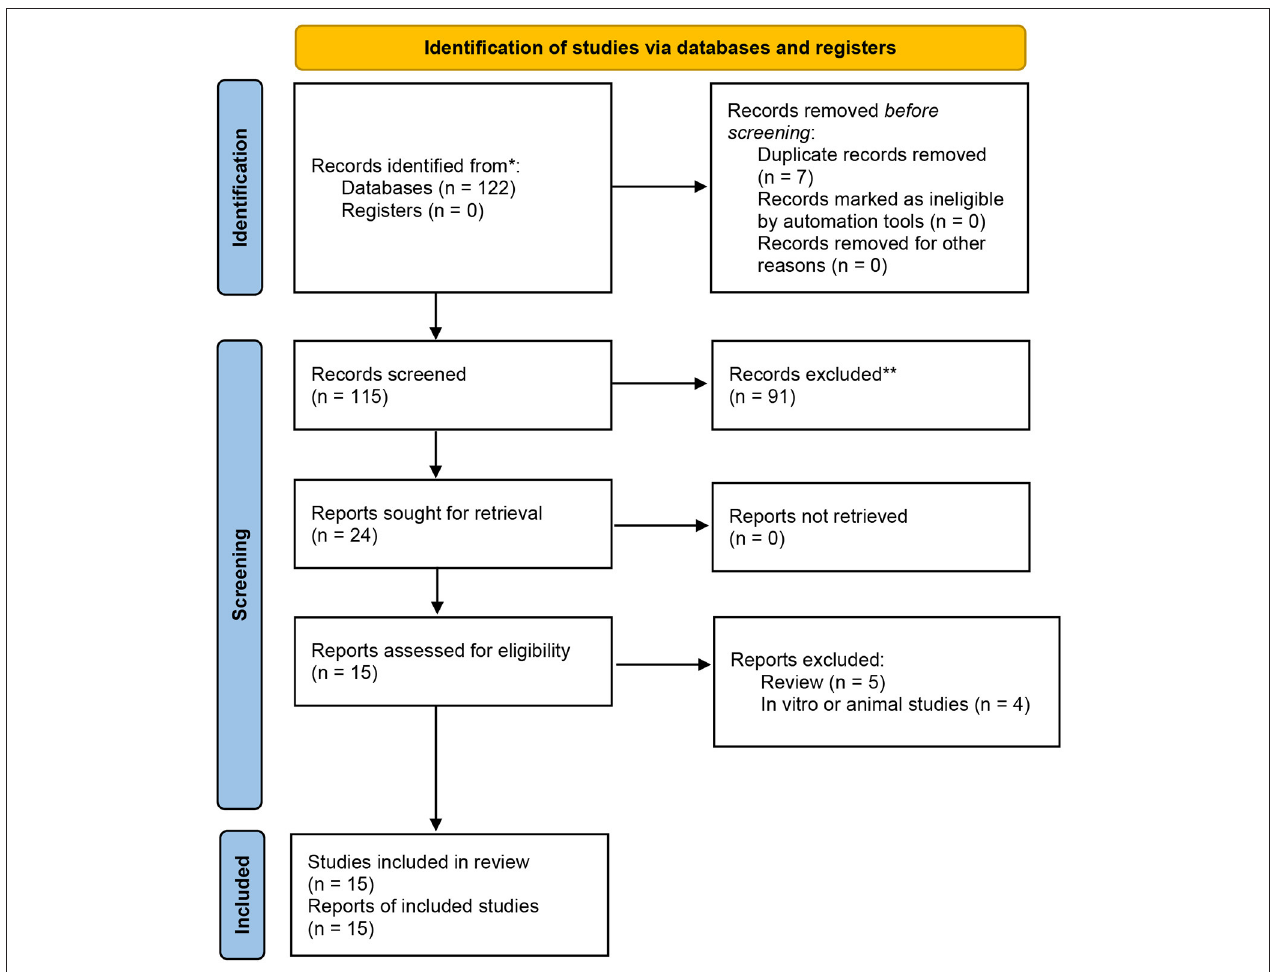
FIGURE 1 | The PRISMA 2020 flow